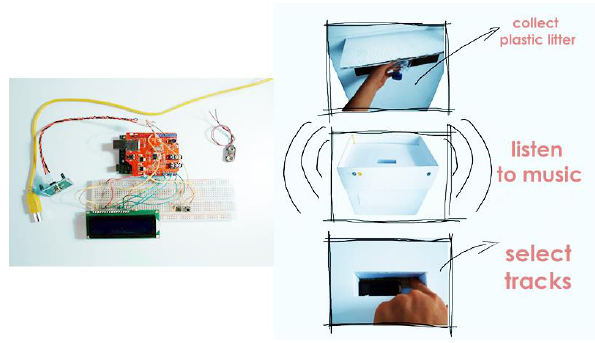
Figure 6. Junkbox Prototype